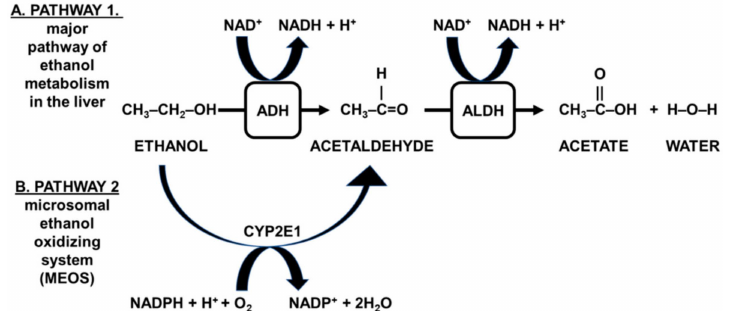
Figure 1. Pathways involved in alcohol metabolism. In the major metabolic pathway ( A ) ethanol is oxidized into acetaldehyde. This oxidative process is facilitated by alcohol dehydrogenase (ADH), which is present in high concentration in the cytosol of hepatocytes. In this second step, acetaldehyde enters the mitochondria where it is oxidized into acetate and water. This process is facilitated by mitochondrial aldehyde dehydrogenase (ALDH). For both steps, nicotinamide adenine dinucleotide (NAD + ) is essential to provide the necessary energy for the conversion, which becomes available when NAD + is converted into NADH + H + . A second major pathway for alcohol breakdown, especially active in subjects who chronically drink alcohol, is the microsomal ethanol oxidizing system (MEOS, see ( B )). The reaction is catalyzed by CYP2E1 and requires nicotinamide adenine dinucleotide phosphate (NADP + ) instead of NAD + to convert ethanol into